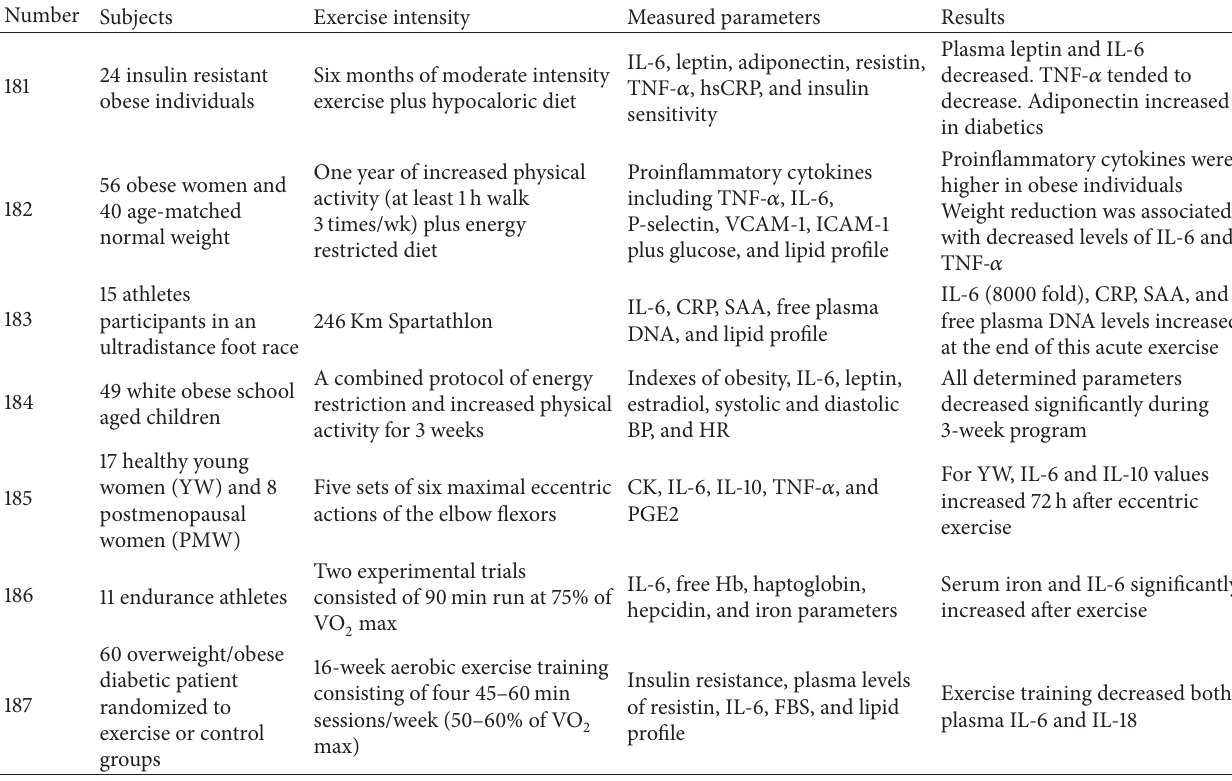
Table 5: Summary of selected clinical trials in which IL-6 level has been measured as a clinical outcome before and after